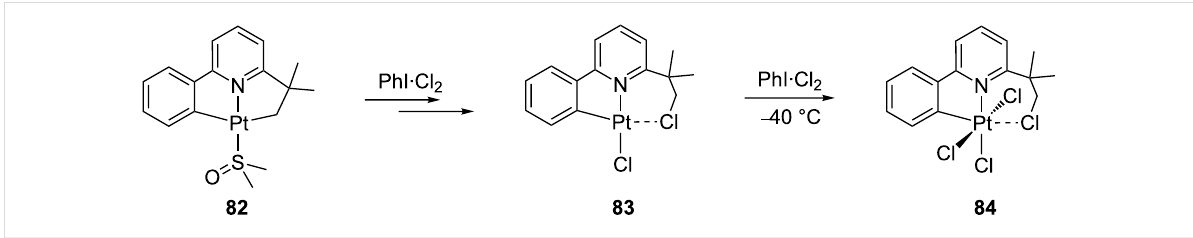
Scheme 36: Cl 2 bond activation through complexes 82 and 83 [144].